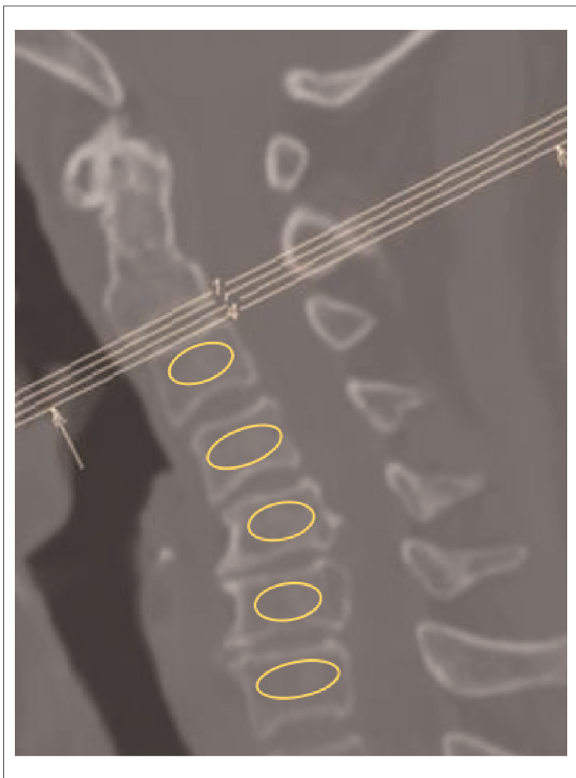
Using an elliptical region of interest function to evaluate the houns fi eld units (HU) value in median sagittal computed tomography (CT) scan of the cervical spine, select the largest possible range of cancellous bone without including cortical bone.